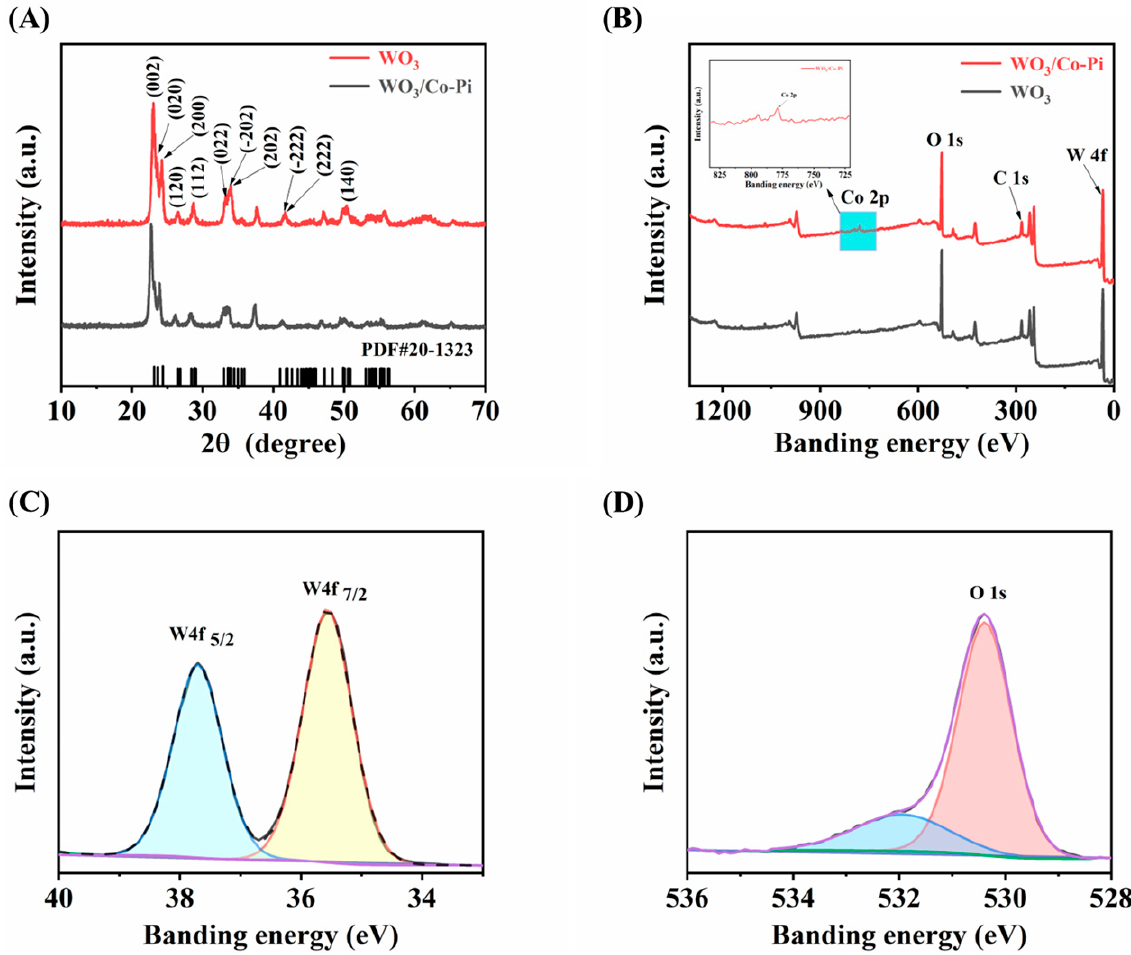
Figure 1. ( A ) XRD patterns of WO 3 film and Co-Pi/WO 3 film; ( B ) XPS patterns of WO 3 film and Co-Pi/WO 3 film; ( C ) W 4f XPS spectra of Co-Pi/WO 3 ; ( D ) O 1s XPS spectra of Co-Pi/WO 3 .